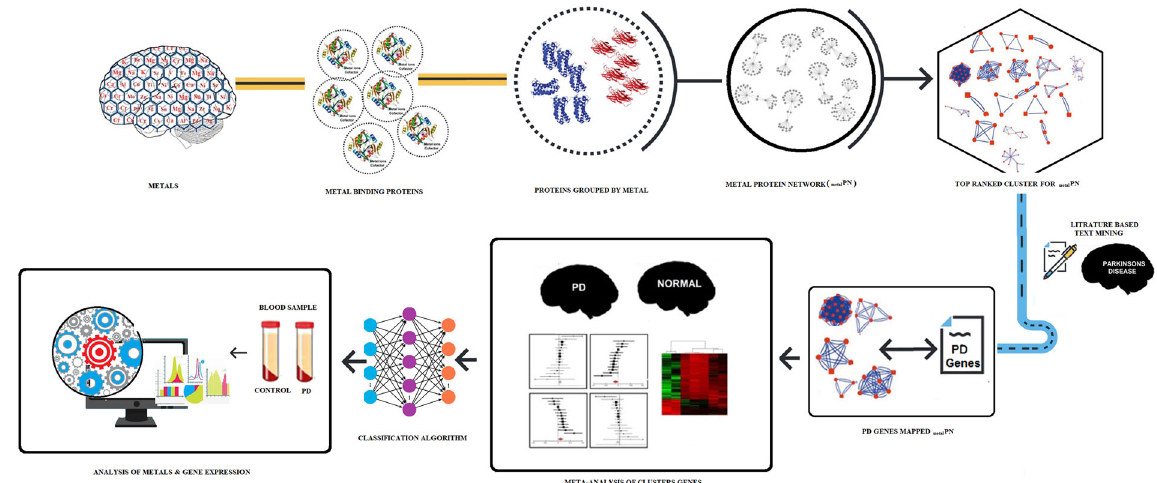
Fig. 1 Systems biology framework describing the work fl ow of data collection, integration and analysis of metals and metal-binding proteins in Parkinson ’ s disease.